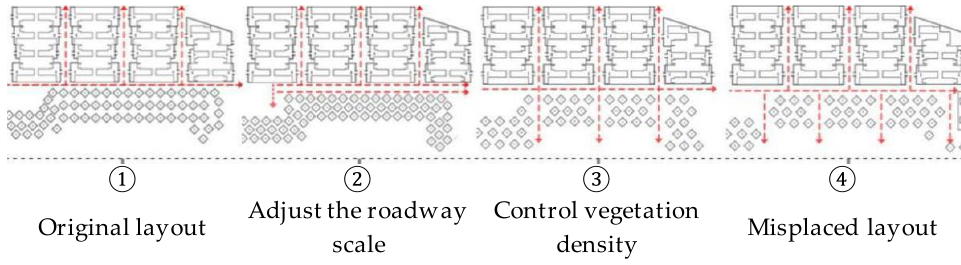
Figure 6. Optimization process of external wind flow organization.